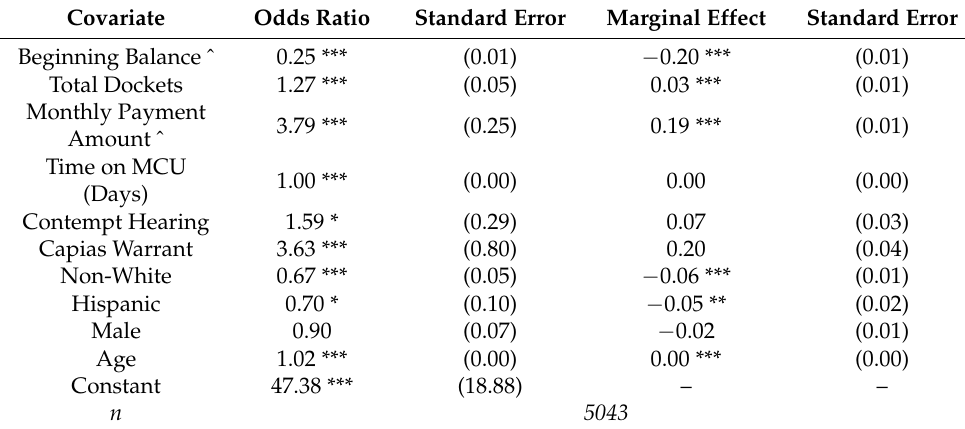
Table 3. Predictors of Full LFO